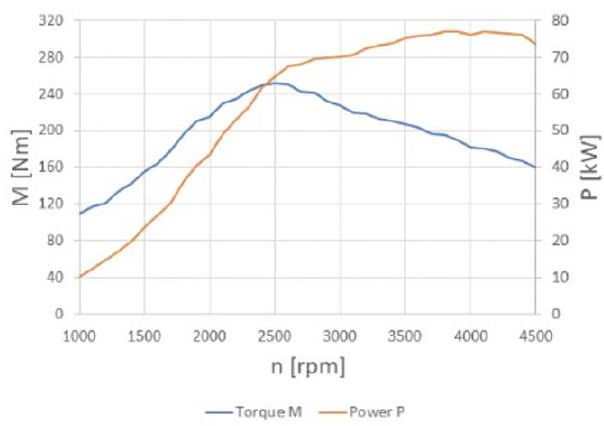
Fig. 8. The corrected model of the fluid domain from Fig. 7 after introduc- Fig. 6. Characteristics of a CI engine of Opel Zafira 1.7 CDTi (own ing modelled layers of carbon source)